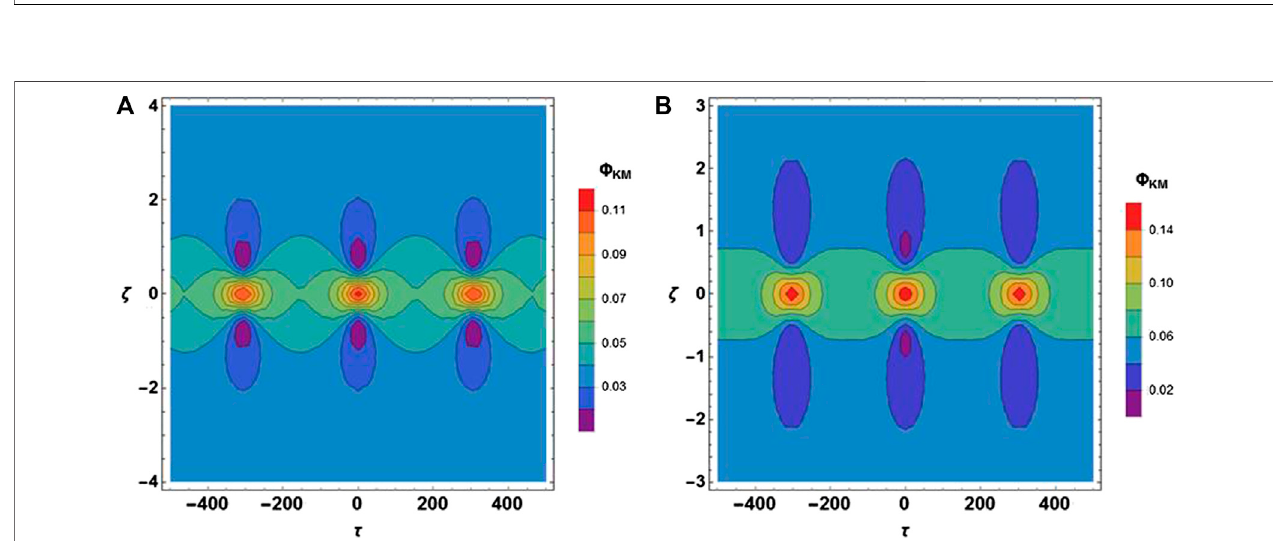
FIGURE 4 | The variation of DA Akhmediev breathers pro fi le in ζ - τ plane (A) for α (cid:1) 0 . 2 and (B) α (cid:1) 0 . 3 at fi xed values of R (cid:1) 0 . 11 and ρ (cid:1) 1 . 11.